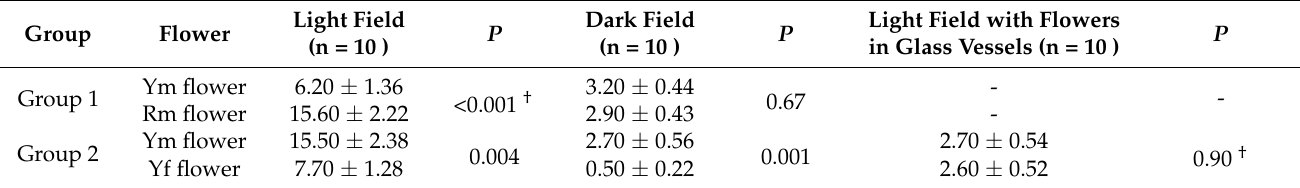
Table 2. Visiting response (mean ± SE) of gall midges to Schisandra sphenanthera flowers in the box experiments. The difference † among flowers was assessed by the independent sample t -test; non-normal distributions were tested using the Mann–Whitney U test (Ym = yellow male, Rm = red male, Yf = yellow